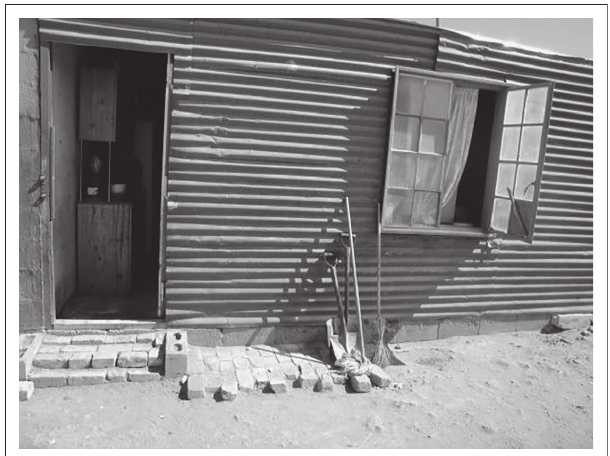
FIGURE 2: Example of a more robust backyard structure.